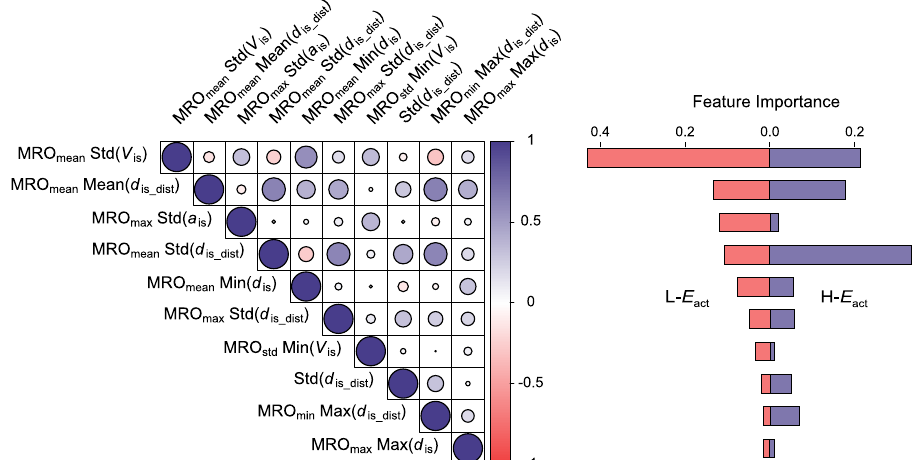
Fig. 4 Interpreting the ML models. a Pearson correlation coef fi cient of the ten features that survived the feature reduction. The coef fi cient value is encoded in the color while the circle radius encodes the absolute coef fi cient value. V is , a is and d is represent the volume, area, and distance interstices, respectively, and the symbol before brackets, i.e., Std, Mean, Std, Min, denotes the statistics of these interstices in the nearest-neighbor (SRO) environment. If there is MRO stat in the feature name, this means that the SRO feature has been coarse-grained among neighbors, i.e., taking the statistics, as denoted by the subscript of MRO, among neighbors. The subscript “ dist ” in d is-dist indicates that the neighbors are determined by a cutoff distance rather than by the default Voronoi tessellation. b Feature importance of the ML models trained in the H- E act and L- E act tasks. The feature importance is averaged over models obtained from the three times of data undersampling and fi ve- fold cross-validation in each data